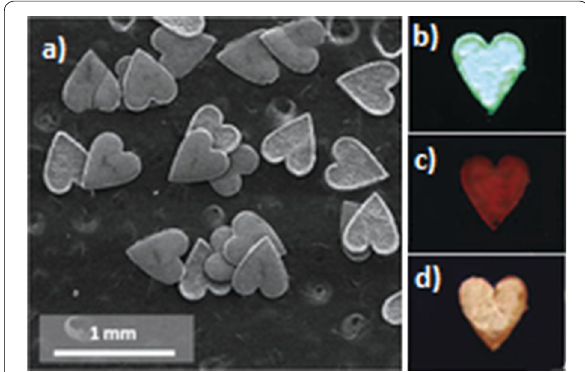
Fig. 3 a SEM image of shape-controlled HKUST-1; b – d photographs of luminescent lanthanide MOF (LnBTC) (BTC 1,3,5-benzenetri- = carboxylic acid) superstructures under exposure of UV light with wavelength of 265 nm; b green TbBTC, c red EuBTC, d apricot hetero- lanthanide MOF (Eu:Ce:Tb 25:20:55) (Reproduced with permission = from Ref. [48]. Copyright 2016 Wiley–VCH) Fig. 4 Schematic synthesis (top) and enzymatic cycle of multi- enzyme containing ZIF-8 (bottom) (Adapted from Ref. [51] with permission of The Royal Society of